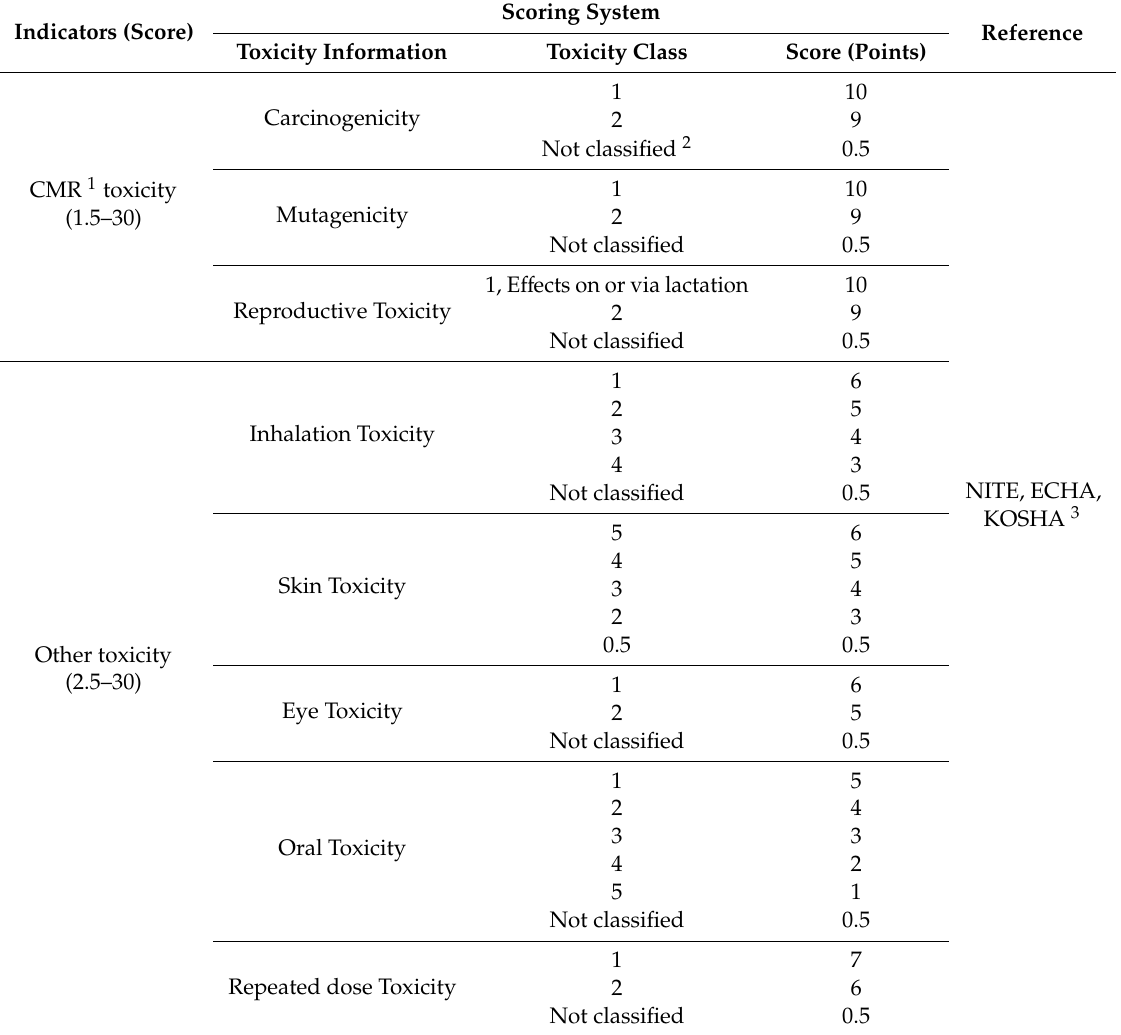
Table 2. Toxicity index scoring